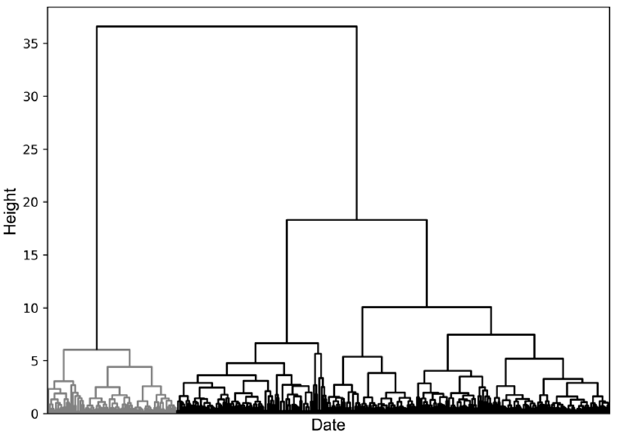
Figure 6. Dendrogram of the clustering